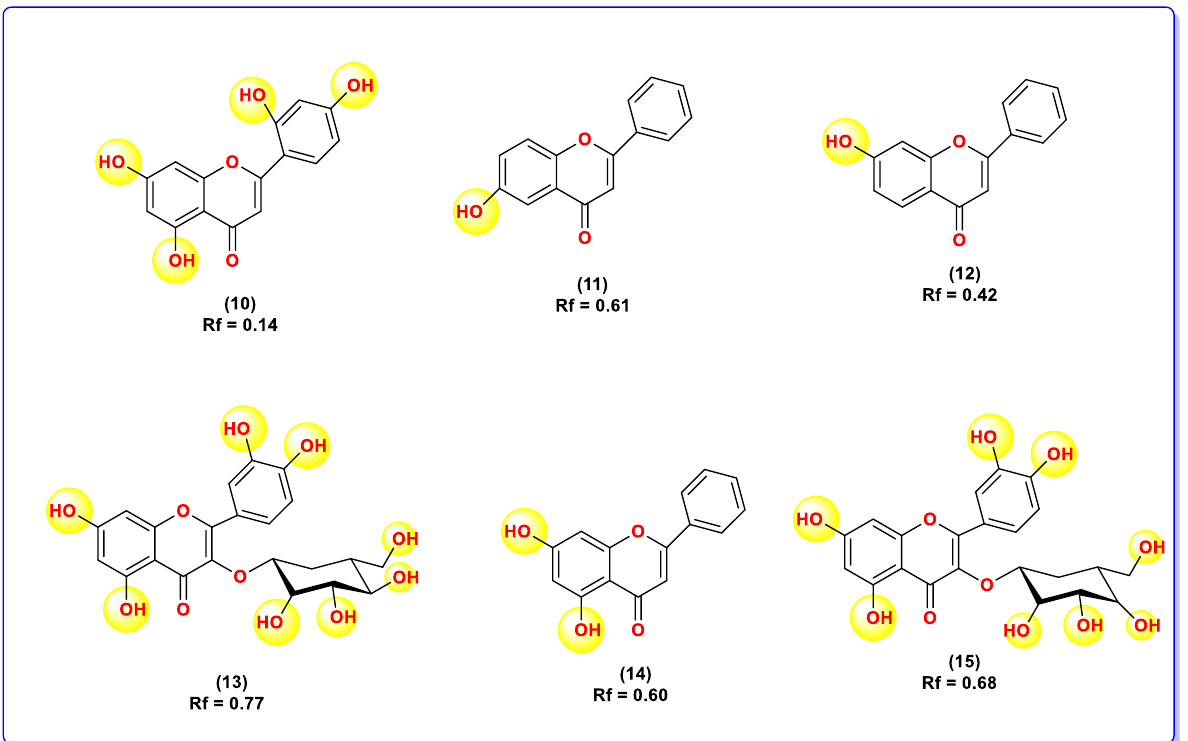
Fig. 7 Identified Phyto-constituents of B. pinnatum. R f 0.60 Chrysin, R f 0.77, 0.68 Iso-quercetin and hyperosides, R f 0.42 7-hydroxy flavone, R f at 0.14, 0.61 morin and 6-hydroxy